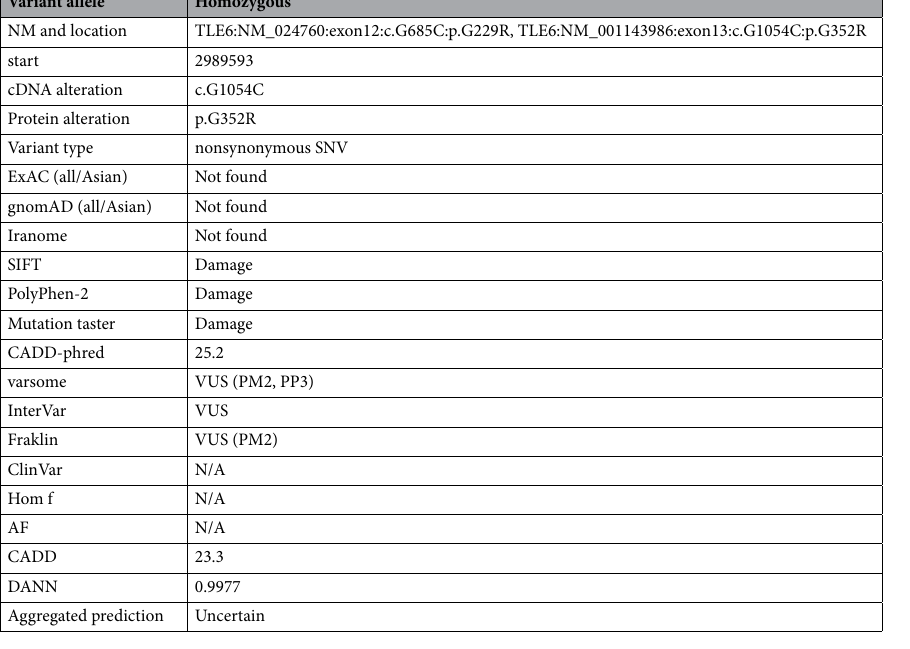
Table 2. Characteristics of the identified variant in the current study.